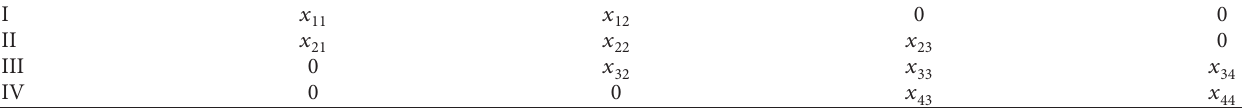
Table 12: Subjective evaluation index membership evaluation table hypothesis